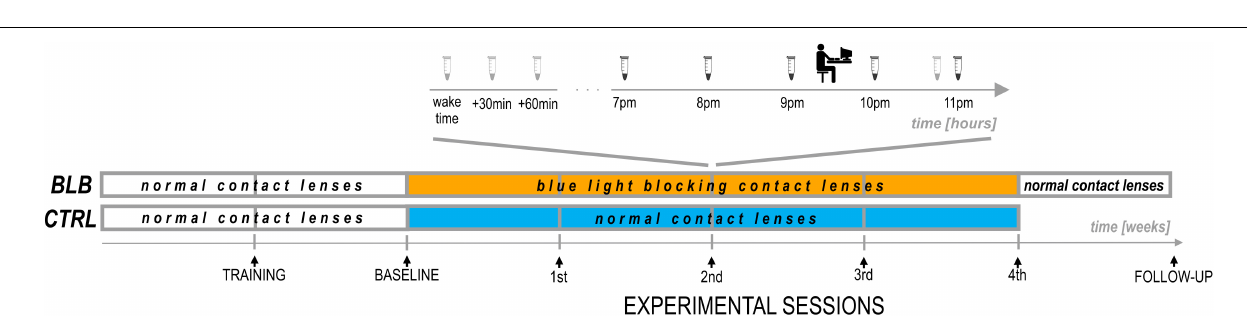
FIGURE 2 | Experimental